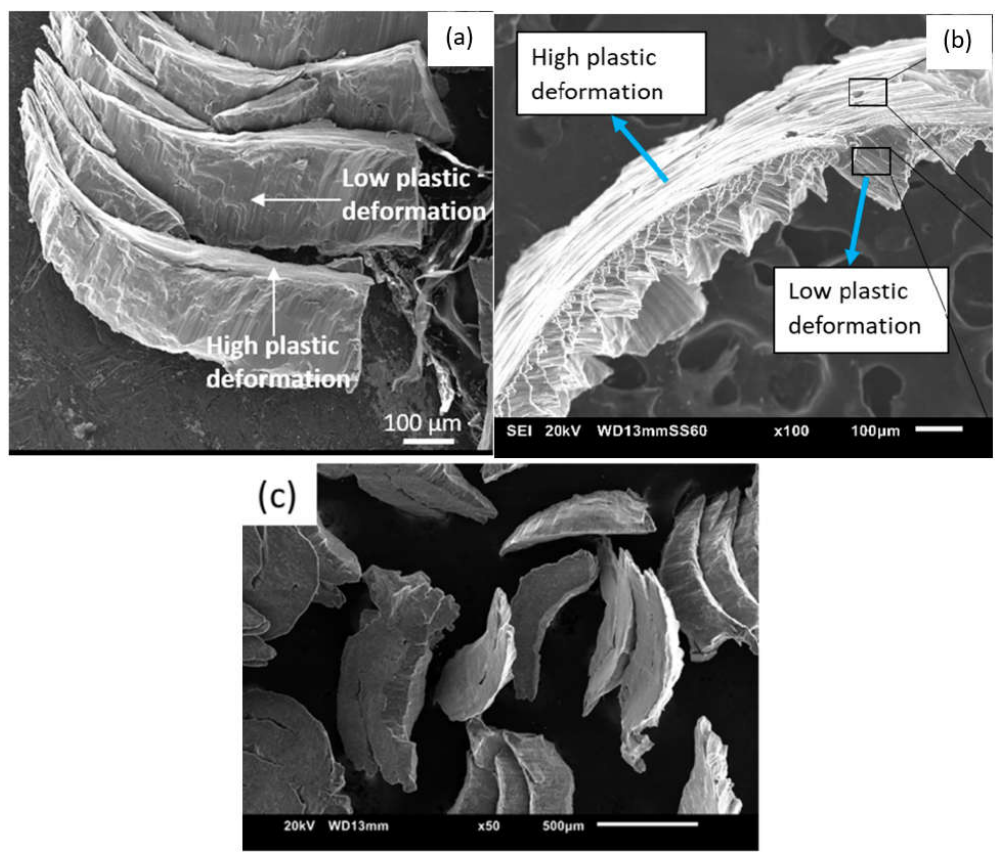
Figure 2. Micrographs of Mg-material turnings, showing plastic deformation zones for ( a ) AZ91 alloy, ( b ) Mg/Fe 3 O 4 nanocomposites, and ( c ) ZK60 alloy. [18,24,25].